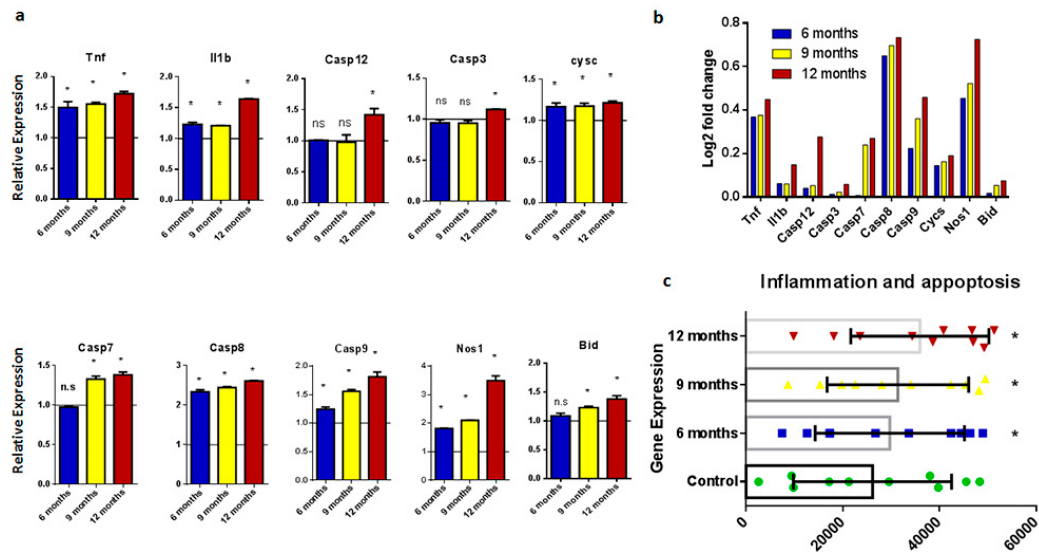
Figure 6. Expression analysis of genes involved in neuroinflammation and apoptosis. ( a ) Histograms representing relative mRNA expression of Tnf , Il1b , Casp 3 , Casp 7 , Casp 8 , Casp 9 , Casp 12 , Nos1 , Cysc , and Bid . Represented values are the mean and SD obtained from three individual experiments performed for each sample. The line on the x-axis at 1.0 represents the gene expression of control samples. ( b ) Bar plots representing fold-change values represented in the log2 scale showing comparative gene expression in the brain of six-, nine-, and 12-month-old samples. Baseline shows expression in control samples. ( c ) Scattered-dot plot showing expression of genes involved in calcium signaling. * Expression is significantly different to WT ( p ≤ 0.05). n.s., Nonsignificant.